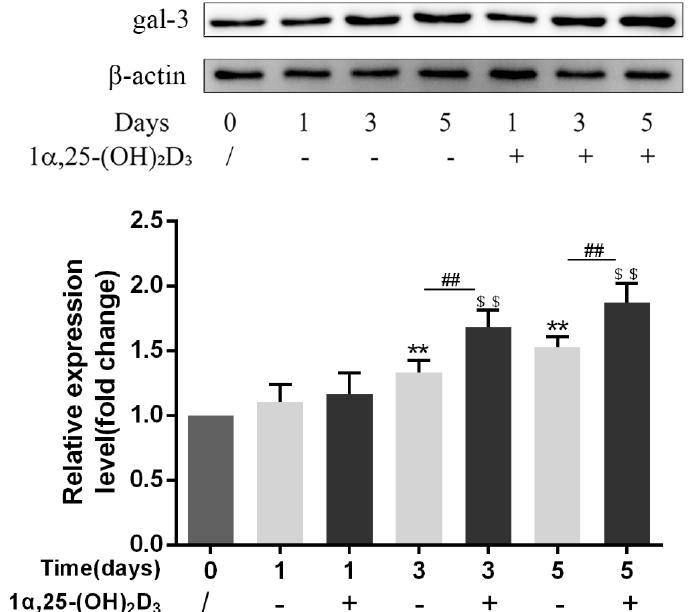
Figure 3. Gal-3 protein expression was upregulated by 1 α ,25-(OH) 2 D 3 at the same cultivation time. Histograms show relative expression levels of gal-3 protein. Data are shown as means ± SD. n = 3, ** p < 0.01 vs. the 0 d group; $$ p < 0.01 vs. the 1 α ,25-(OH) 2 D 3 treatment group on day 1; ## p < 0.01 vs. different groups on the same day. To further confirm the effect of 1 α ,25-(OH) 2 D 3 on gal-3 protein distribution, an im- munofluorescence assay was performed. The gal-3 protein was visualized by green fluo- rescence, while F-actin was visualized in red on day 6 after treatment with 10 nmol/L 1 α ,25-(OH) 2 D 3 . Anhydrous ethanol was used as a control. Gal-3 mainly distributed in the nuclei (cyan) and cell membranes (yellow) of OCs (large cells with more than three nuclei marked by white triangles) and in the whole OCPs (small cells with one nucleus marked by white arrow) (Figure 4). Compared with OCs, OCPs had a wider green fluorescence distribution of gal-3. These data confirmed that 1 α ,25-(OH) 2 D 3 changed the protein distri- bution of gal-3.